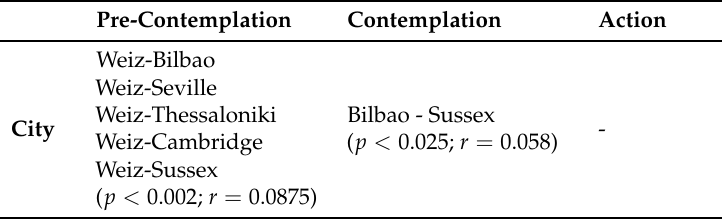
Table 7. PRE-pilot: Post hoc analysis to identify where the differences are in the effect that we observed after running Kruskal-Wallis test. In Pre-contemplation it seems that Weiz scored differently to other pilots. Specifically, people in Weiz pilot scored higher the Pre-contemplation stage than the rest of the